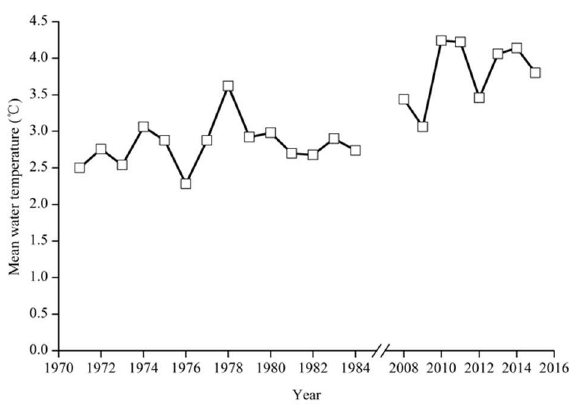
Figure 5. Variation of the mean temperature of the flow released from the Qingtongxia station during the ice jam flooding seasons.